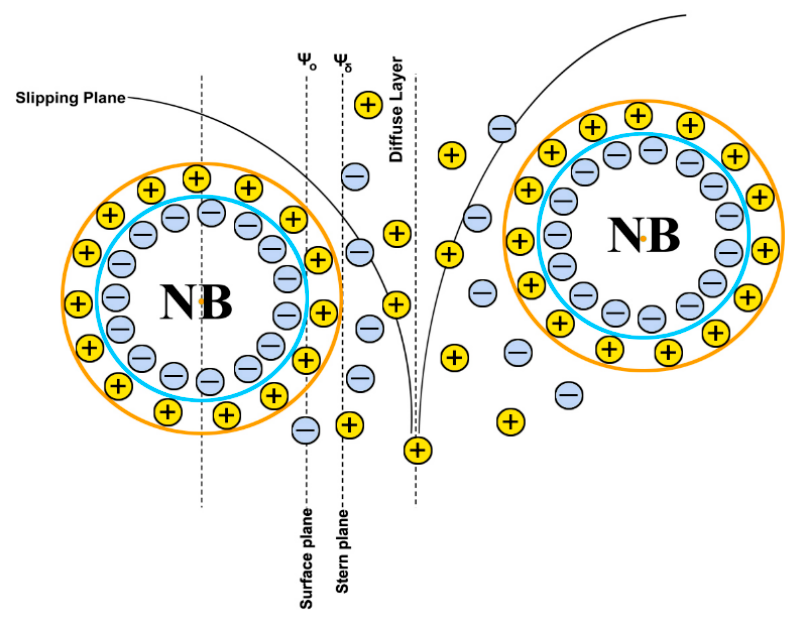
Figure 6. The electrical double layer for bNBs; Ψ δ is the potential at the boundary between the compact and diffuse layers.